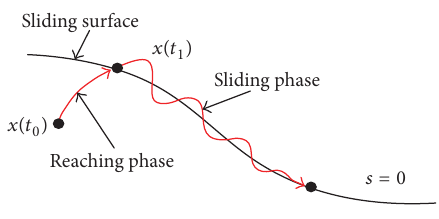
Figure 4: Generic sliding